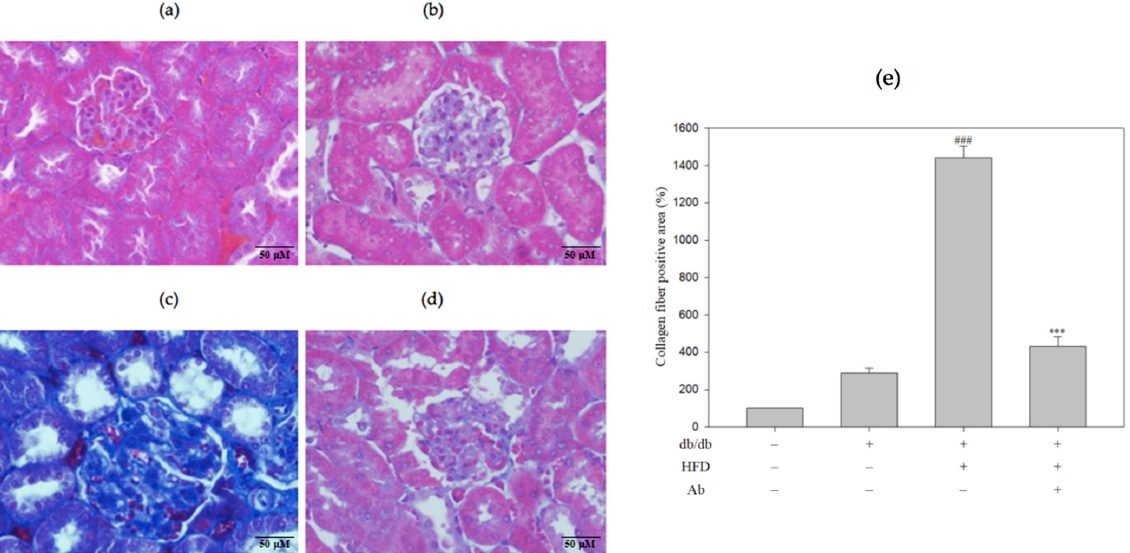
Figure 4. Ab reduced collagen fiber expansion in the kidneys. Kidney slices were embedded in paraffin and stained by Masson’s trichrome reagent. Light photomicrographs of kidney sections from ( a ) control group (C57BL/6 mice), ( b ) db/db group, ( c ) db/db+HFD group, ( d ) db/db+HFD+Ab group were displayed (400 × magnification). The blue color on the renal biopsy represented the expression of collagen fiber. ( e ) Quantification of the collagen fiber-positive area. Data are presented as mean ± SD; n = 3 mice per group. The results were analyzed using Student’s t -test. ###, p < 0.001 compared with the control group. ***, p < 0.001 compared with the db/db+HFD